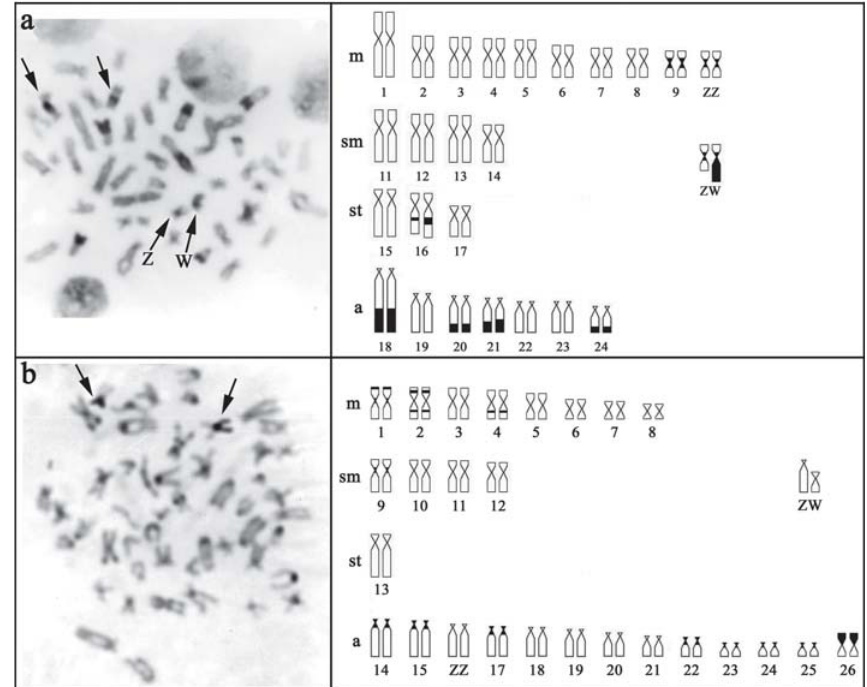
Fig. 4. Metaphase and idiogram showing the distribution of constitutive heterochromatin after C-banding technique in Ancistrus ranunculus (a) and in Ancistrus sp. “Piagaçu” (b). Arrows indicate the NOR-bearing chromosomes with positive C- banding. m= metacentric; sm= submetacentric; st= subtelocentric; a=